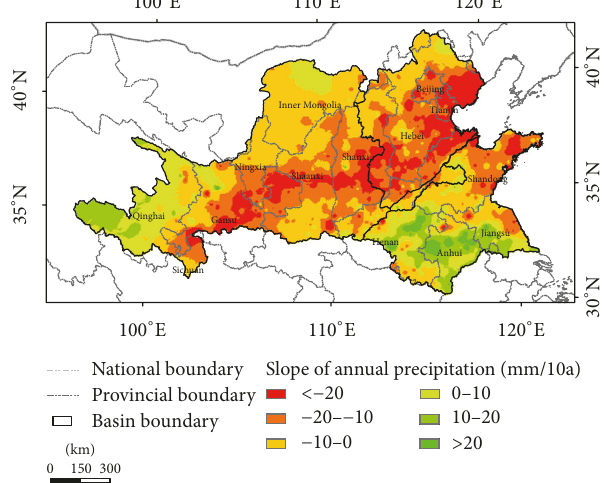
Figure 4: Precipitation trends from 1961 to 2011.